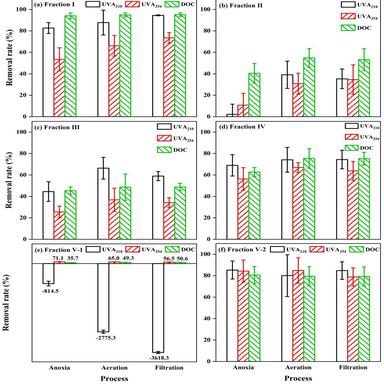
Removal rates of HPSEC fractions (a) I, (b) II, (c) III, (d) Ⅳ, (e) Ⅴ− 1 and (f) Ⅴ− 2 after different process units calculated with UVA210, UVA254 and DOC chromatographic area. Mean±SD (n = 13). HPSEC: high-performance size exclusion chromatography; UVA: ultraviolet absorbance; DOC: dissolved organic carbon.